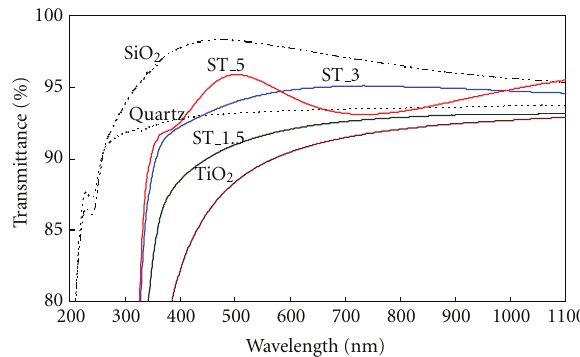
Figure 4: Transmittance spectra of TiO 2 , SiO 2 , and ST serial composite thin films coated on quartz glass and heated at 700 ◦ C for 5